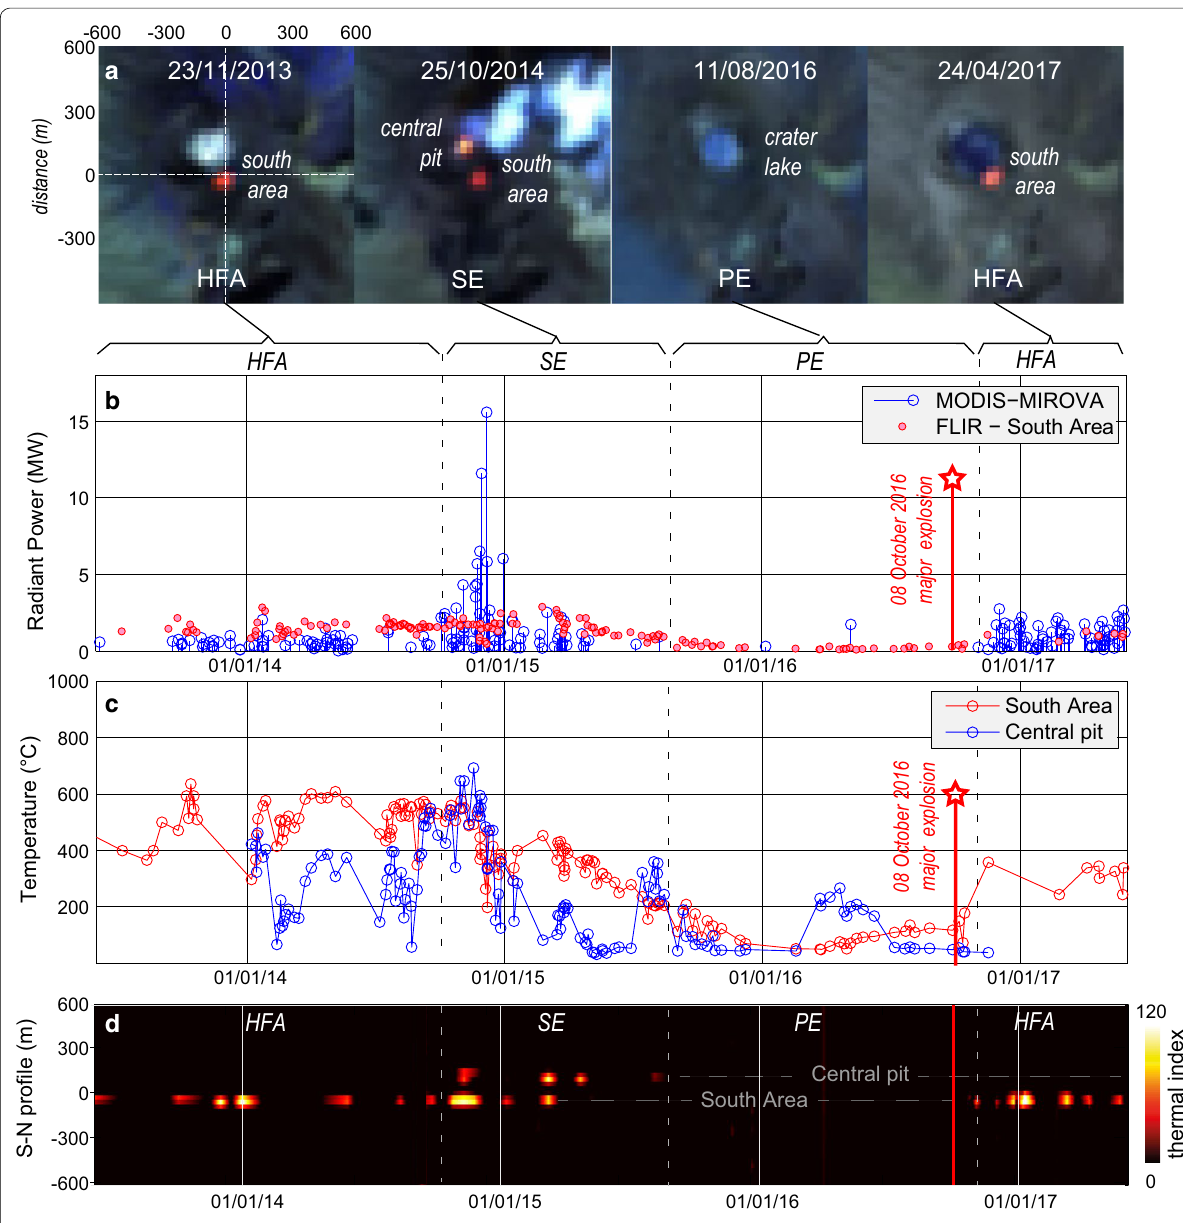
Fig. 7 Graphic summary of the 2014–2017 thermal activity of Aso Volcano by means of satellite and ground-based data; a selected sectors of LANSAT8 images showing the location of the thermal anomalies during different phases of activity within the Nakadake crater; b Time series of radi- ant power detected by MIROVA (blue stems) and by the FLIR thermal camera (red circles) relative to the fumarole field on the South Area; c Maxi- mum temperature recorded on the South Area (blue) and Central Pit (red), obtained from ground-based thermal cameras. d N–S profiles of thermal index related to the high-resolution images reported above (see Sect. 3.2). Colors refer to the intensity of the thermal anomaly. The positions along the S–N profile indicate what area was thermally active at the time of